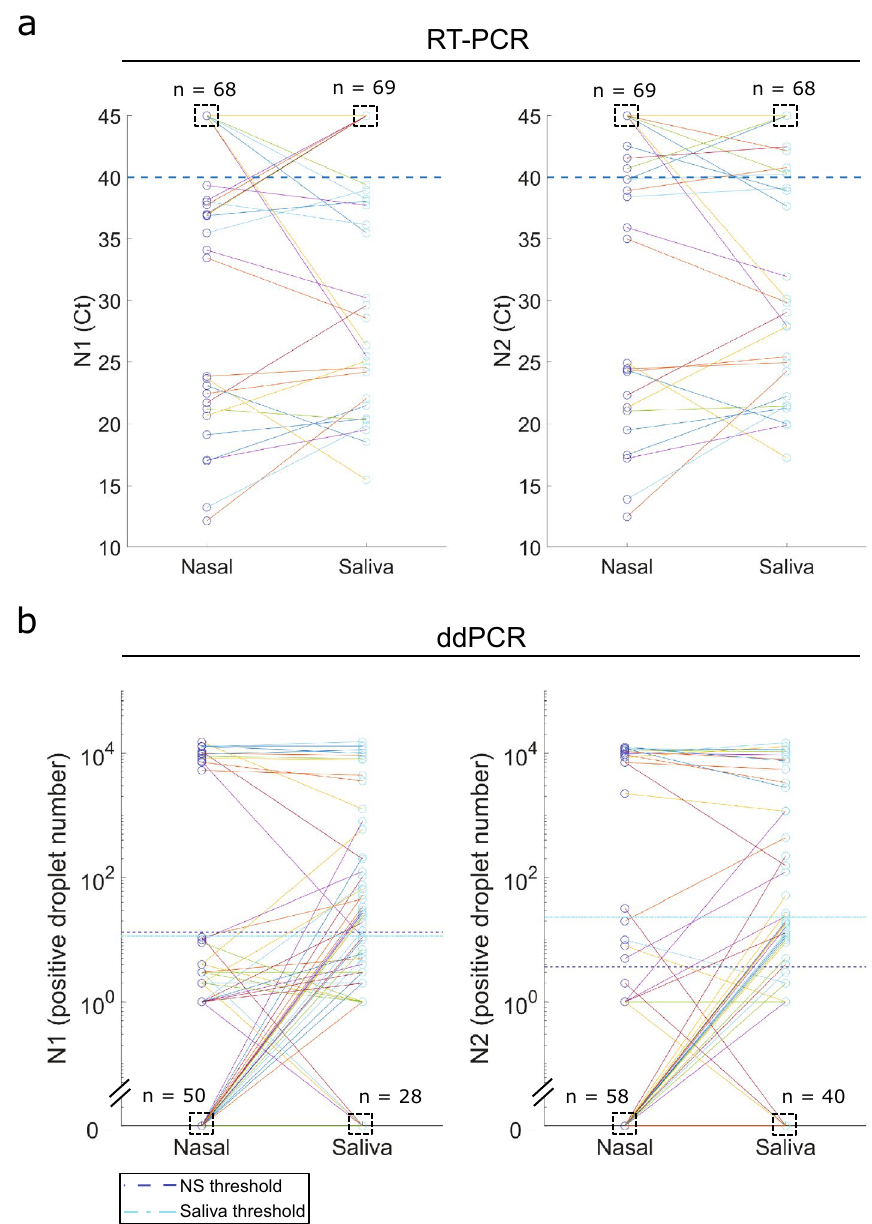
Figure 3. Comparison of research RT-PCR (a) and ddPCR (b) results between nasal swab and saliva. ( a ) Dashed boxes indicate number of negative samples with Ct value of 45. The number of nasal swab specimens with Ct value of 45 for N1 and N2 was 68 and 69 respectively, whereas the number of saliva samples with Ct value of 45 for N1 and N2 was 69 and 68 respectively. There were 9 and 7 nasal swab samples that were negative for N1 and N2 respectively, but these patients were detected as positive for these targets in matched saliva samples. There were also 3 and 3 nasal swab samples that were positive for N1 and N2 respectively, but called negative for these targets in matched saliva specimens. Per CDC recommendations, a sample is called positive if either N1 or N2 are below the RT-PCR thresholds. ( b ) Dashed boxes indicate number of samples with readout of 0. The total number of negative samples with concentration readout of 0 for N1 in nasal swab and saliva specimens was 50 and 58 respectively, while the number of negative samples with concentration readout of 0 for N2 in nasal swab and saliva specimens was 28 and 40 respectively. The number of nasal swab negative but saliva positive results are 19 (N1) and 5 (N2) and the number of nasal swab positive but saliva negative results are 1 (N1) and 3